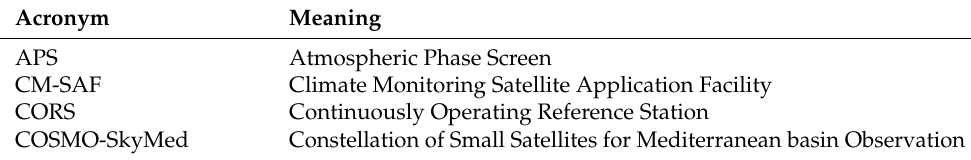
Table A1. Acronyms